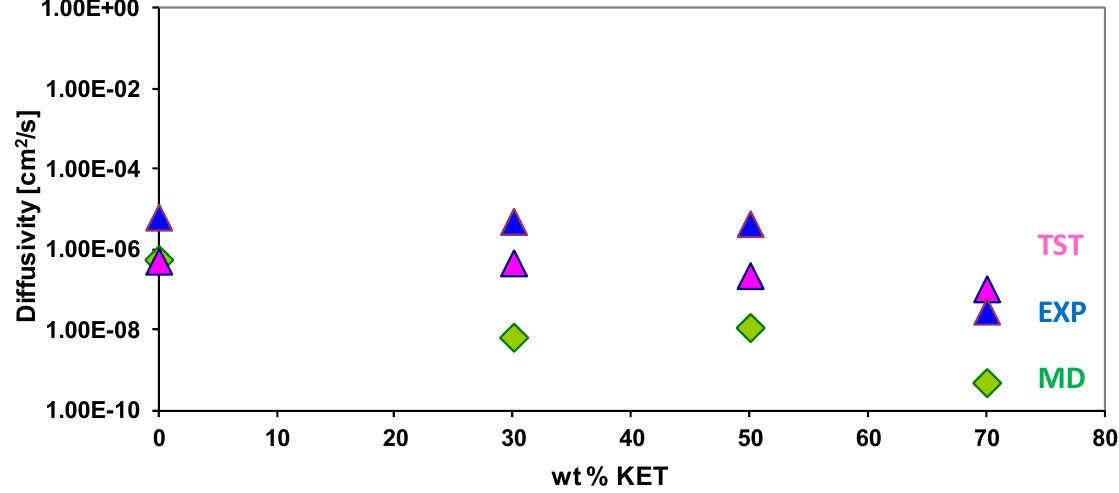
Figure 7. Experimental and theoretical diffusivity of H different wt % of